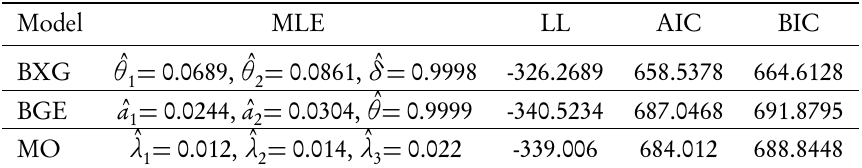
The MLEs of the parameters, copula parameter estimate, the log-likelihood values, AIC and BIC